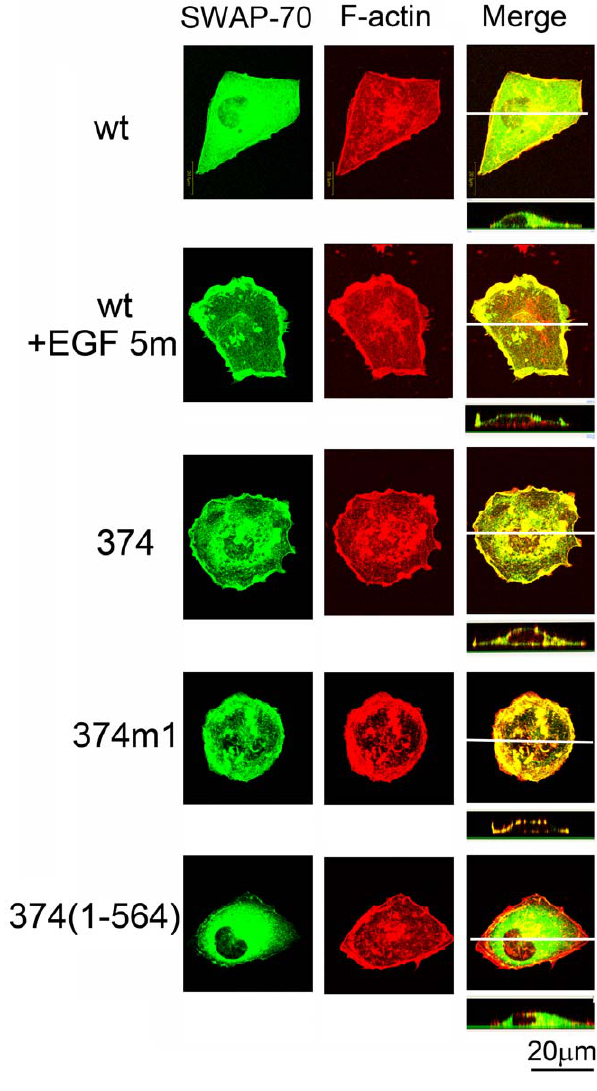
Figure 3. Localization of mutant SWAP70s. Expression vectors for GFP-SWAP-70, GFP-SWAP-70-374, GFP-SWAP-70-374m1, and GFP- SWAP-70 (1-564) were introduced into Cos7 cells by eletroporation. The cells expressing GFP-SWAP-70 were stimulated with EGF (100 ng/ ml) for 5 min. After fixation with formaldehyde, cells were stained with TRITC-phalloidin and observed under the confocal microscope. The upper panels show XY images of the cells, while the lower panels show XZ images. The lines in the top panels show the position where XZ images were made.